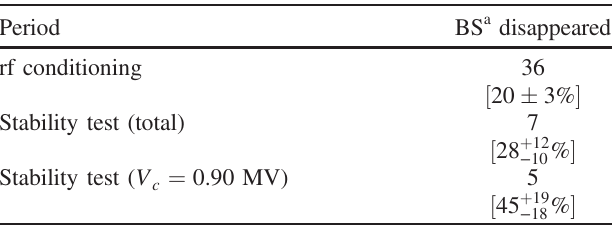
TABLE V. Number of spot-type explosion events with a stable bright spot in which the bright spot disappeared after the explosion. Numbers enclosed in square brackets are percentages of the total numbers of cavity breakdown events with binomial errors for a 1 σ confidence interval.